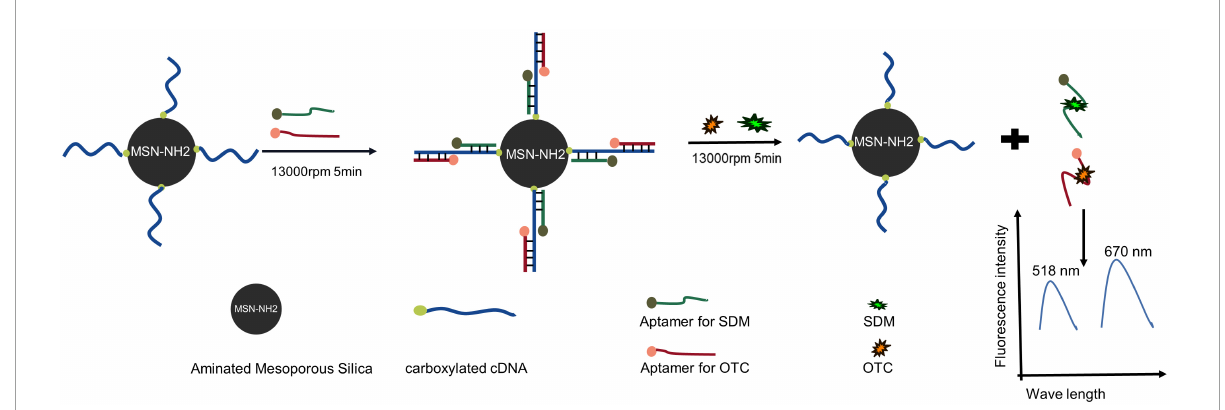
FIGURE1 Schematic diagram of a dual fluorescent aptasensor based on MSN-NH 2 to detect sulfadimethoxine (SDM) and oxytetracycline (OTC).